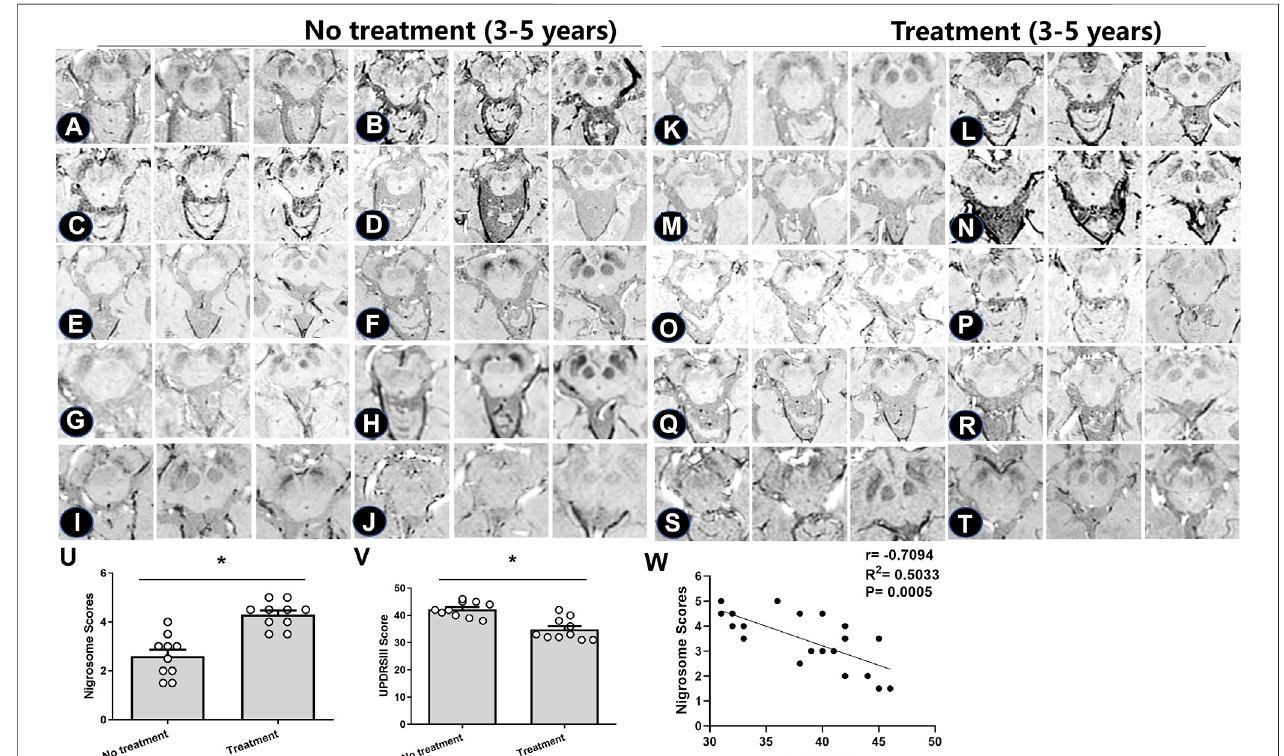
FIGURE3| Irondepositioninthesubstantianigraparscompactainindividualpatientstreatedwithdifferentantiparkinsonmedications. (A – T) SWIimagesof20PD patients. Based on levodopa treatment, the absence of the nigrosome was evaluated and detected. (U,V) Nigrosome scores and UPDRS Ⅲ scores were statistically analyzed in PD patients; * compared with the untreated group, p < 0.05. Mean scores were calculated based on the scores in three axial sections of the brain. (W) Correlation analysis was used to evaluate the relationship between UPDRS Ⅲ scores and nigrosome scores.